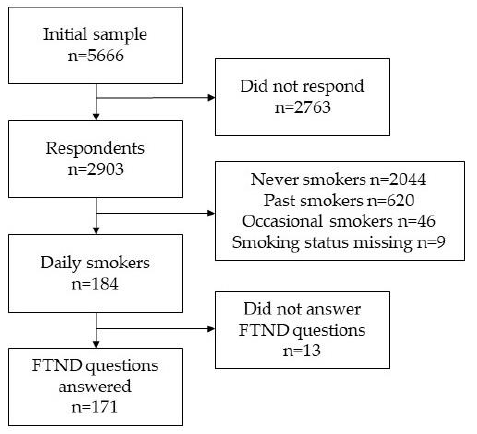
Figure 1. Flow chart of selection of daily smoking physicians from the study sample, postal cross-sectional survey among physicians in Estonia,